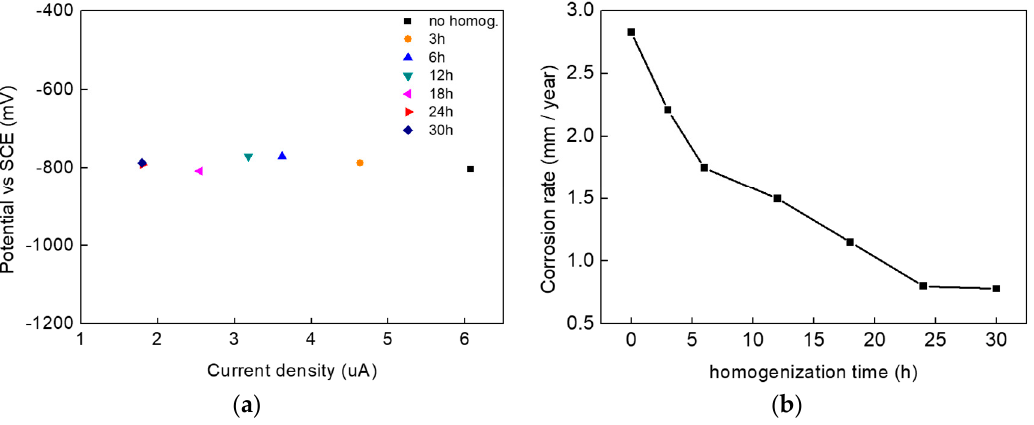
Figure 3. ( a ) Polarization potential obtained from Tafel analysis; ( b ) Corrosion rate calculated from the polarization current density of Tafel analysis.